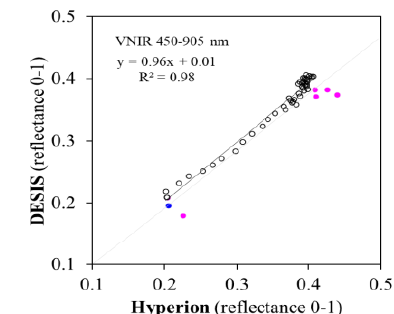
Figure 3. Comparison of the VNIR mean reflectance signals of Hyperion and DESIS convolved to Hyperion bands. The VNIR bands compared well in the 447-905 nm region (in black). The DESIS bands below 447 nm and above 905 nm (in pink) were excluded from further